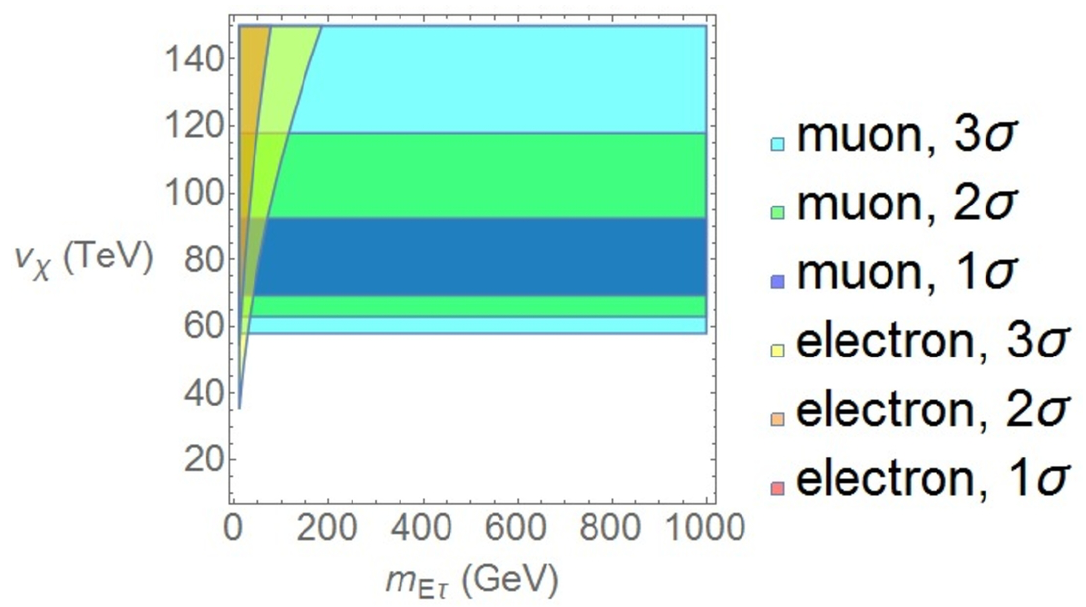
Figure 11 . Same as in (cid:12)gure 9 but now with m E